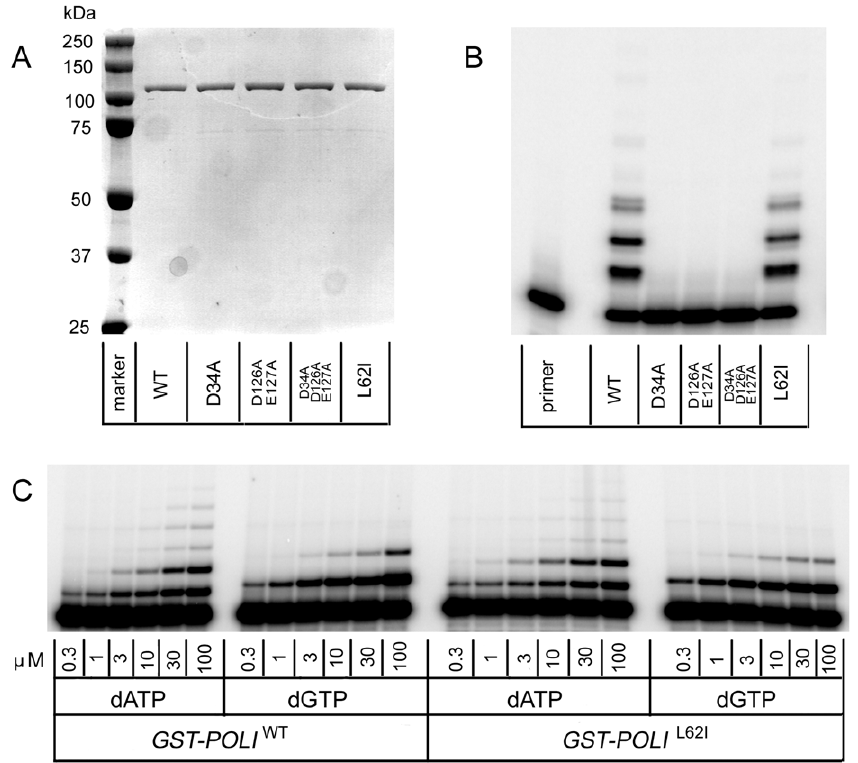
Figure 4. Activity of pure GST-tagged Pol i variants. A. Purification of GST-Pol i and its variants by affinity chromatography: the photograph of a Coomassie brilliant blue stained gel is shown. Equal volumes (15 m l) of each fraction with wild-type GST-Pol i , GST-Pol i D34A , GST-Pol i D126A/E127A , GST-Pol i D34A/126A/E127A , and GST-Pol i L62I eluted from the glutathione-sepharose column were analyzed on 8% SDS-PAGE. B. The comparative DNA- polymerase assay with purified GST-Pol i and its variants. The ability of enzymes to extend a P 32 -labeled 17-mer primer annealed to template 1 was assayed in the presence of 100 m M of all four dNTPs and 0.15 mM Mn 2 + ions, at 37 u C for 5 min. C. Kinetic analysis of dATP and dGTP incorporation by purified wild-type GST–Pol i and GST–Pol i L62I variant. Primer extension reaction was carried out in the presence of 0.15 mM Mn 2 + divalent metal ions and 1 nM of GST-Pol i or its catalytically compromised variant at 37 u C for 2.5 min. To quantify the incorporation of dATP and dGTP opposite template T we varied each dNTP concentration from 0.3 to 100 m M. Kinetic parameters determined from these experiments were: Wild-type: dATP: